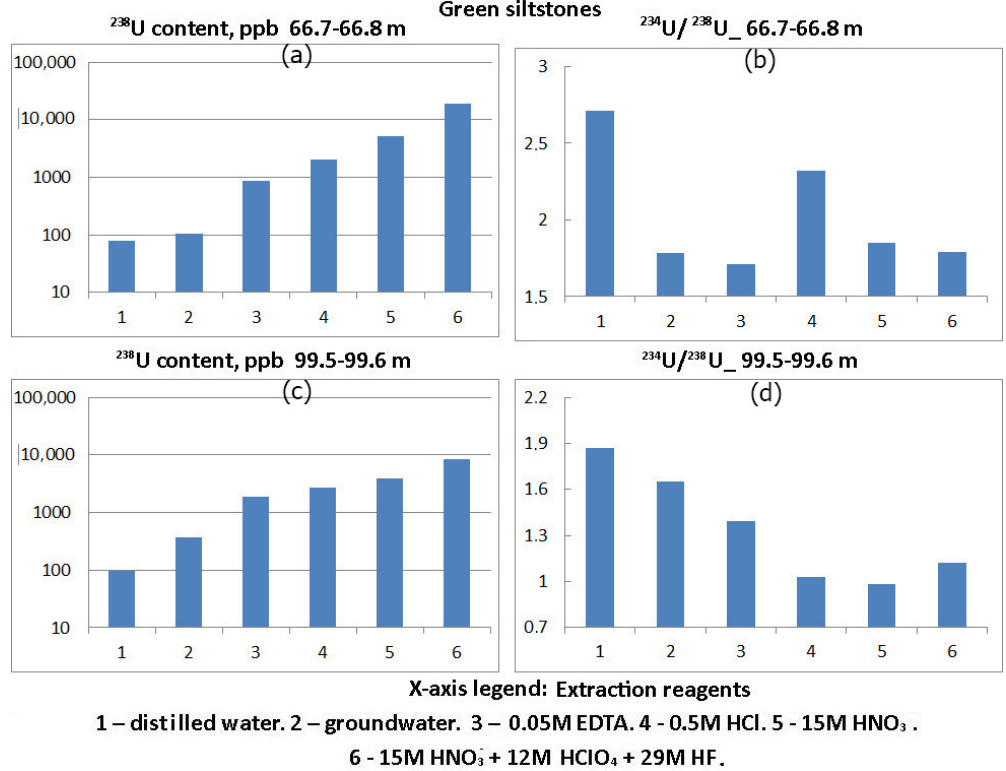
Figure 3. Distribution of 238 U content and 234 U: 238 U activity ratio in phases 1–6, leached from crushed green siltstone of Vendian (Ediacaran) Padun Formations.